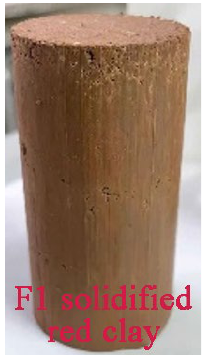
Figure 2. Triaxial specimen.